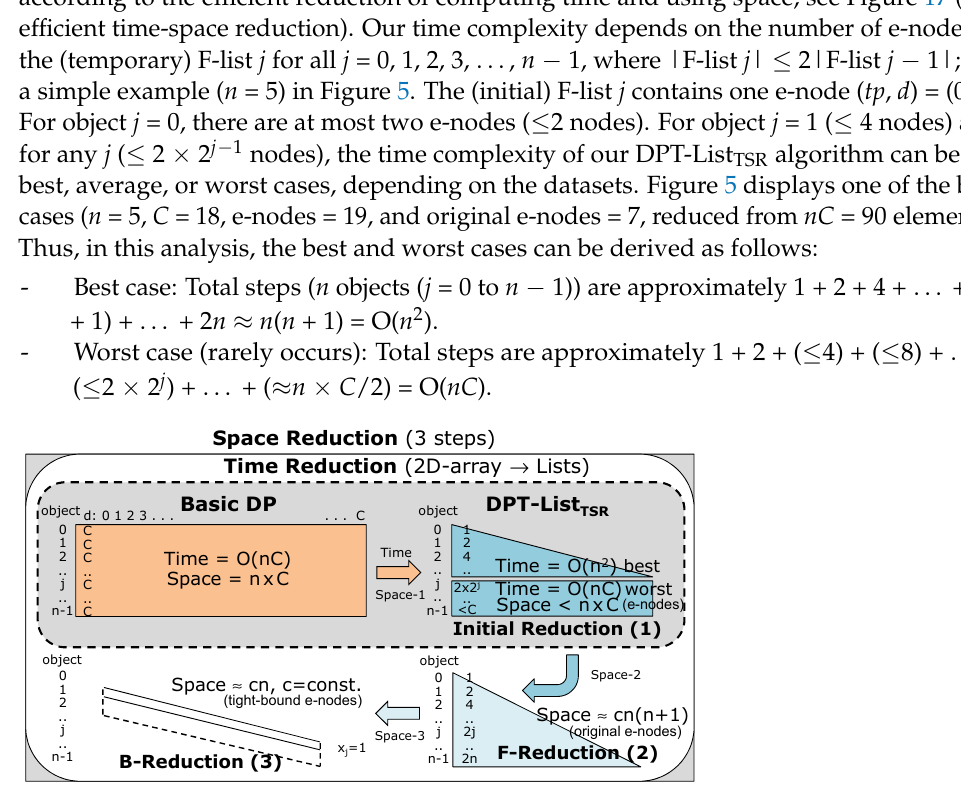
Figure 17. Time and space reduction of DPT-List TSR for the 0/1-KP. The worst case (the e-nodes of F-list n − 1 = |F-list n − 1 | ≈ C ) hardly occurs due to